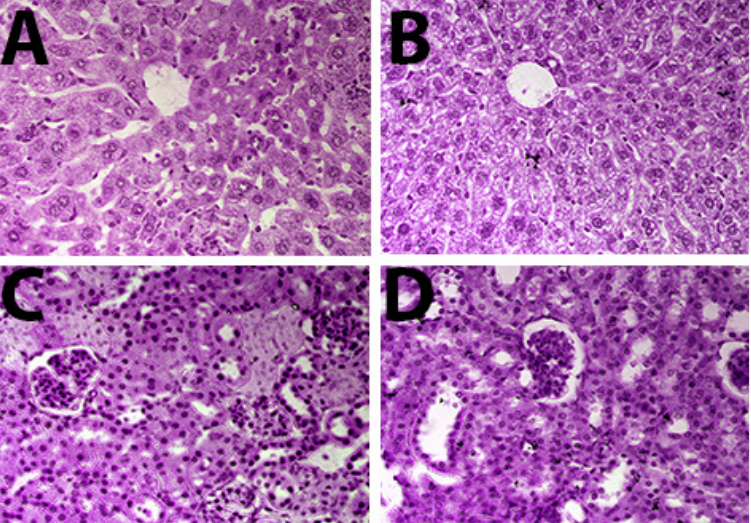
Figure 5. Photomicrographs of H&E ‐ stained liver and kidney sections from Swiss albino mice: ( A ) EAC control liver; ( B ) LGBME ‐ treated liver; ( C ) EAC control kidney; ( D ) LGBME ‐ treated kidney. control liver; ( B ) LGBME-treated liver; ( C ) EAC control kidney; ( D ) LGBME-treated kidney. All All photographs magnified 10 × 40x. photographs magnified 10 ×